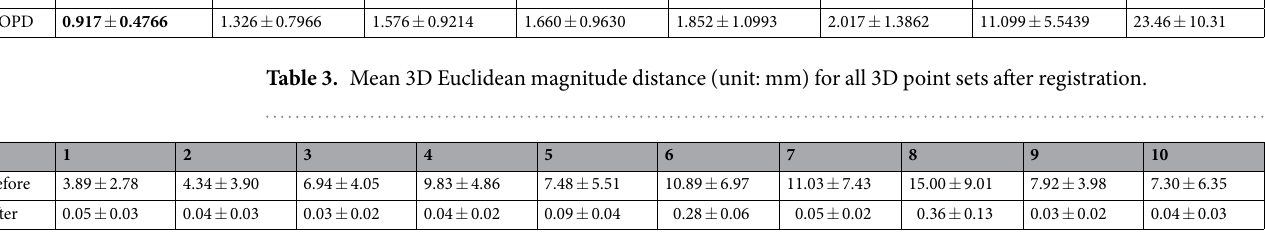
Table 4. Mean 3D Euclidean magnitude distance (unit: mm) between correspondence of T00 and T50 by using DSMM.